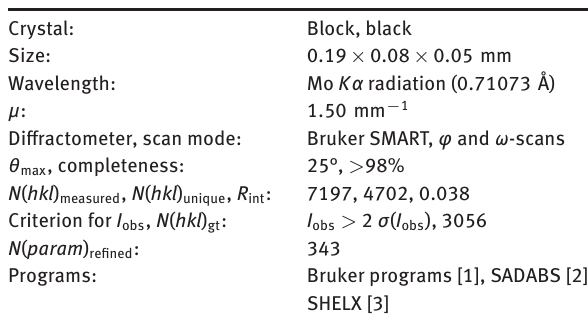
Table 1: Data collection and handling.